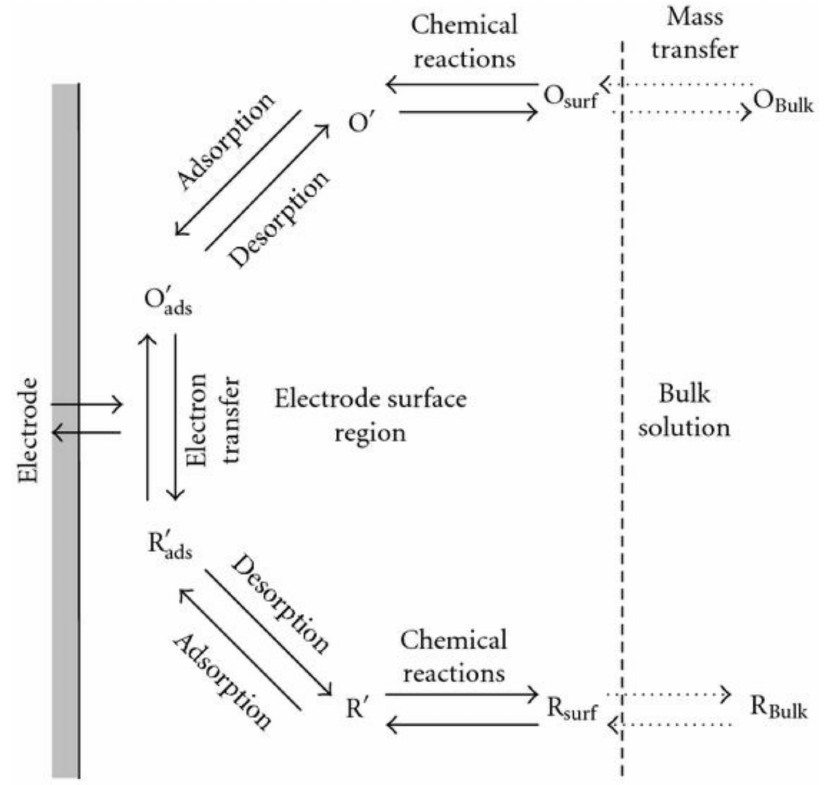
Figure 14. Pathway of a general electrode reaction. Reprinted with permission from [92].